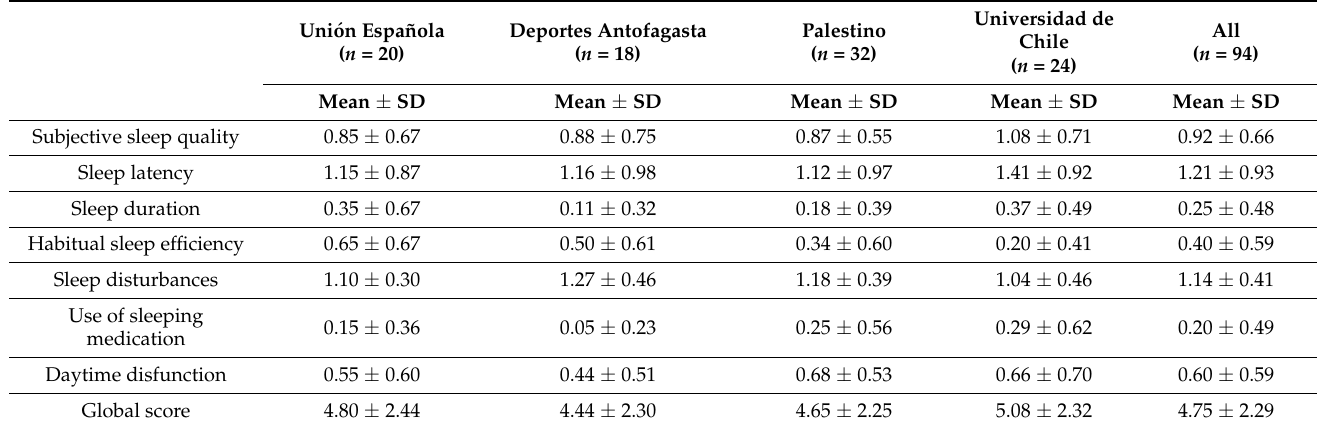
Table 2. PSQI in Chilean male professional soccer players.